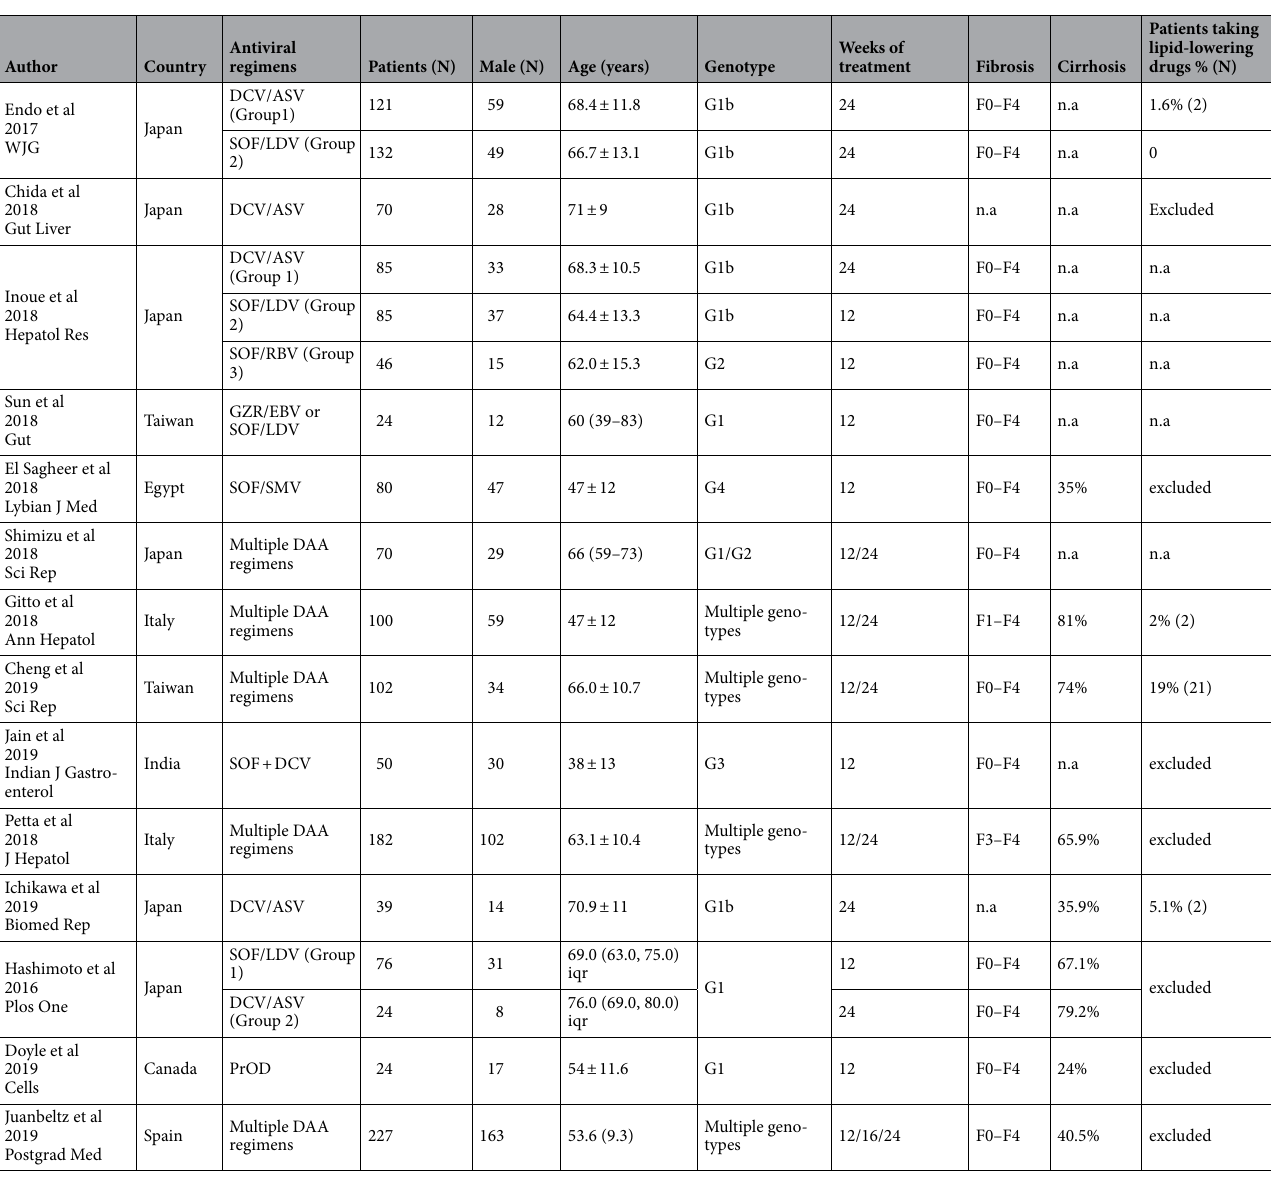
Table 1. Characteristics of included